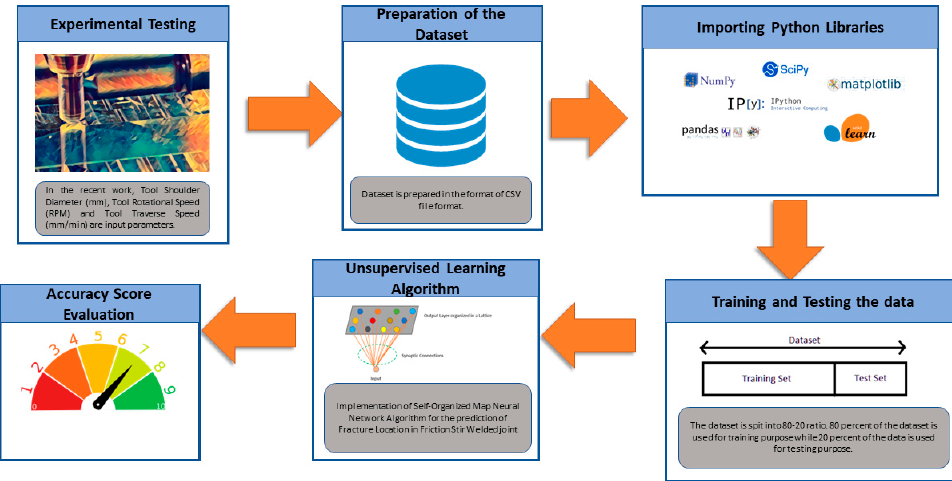
Figure 2. Flow chart of the methodology of unsupervised learning algorithm.